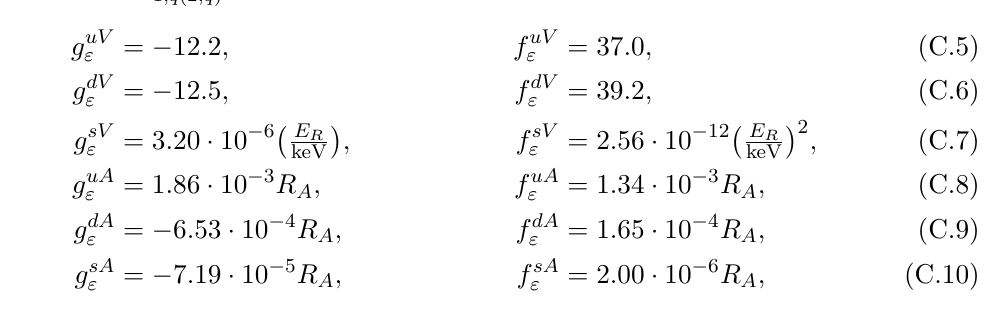
(7) (top) and 8 ,q Q